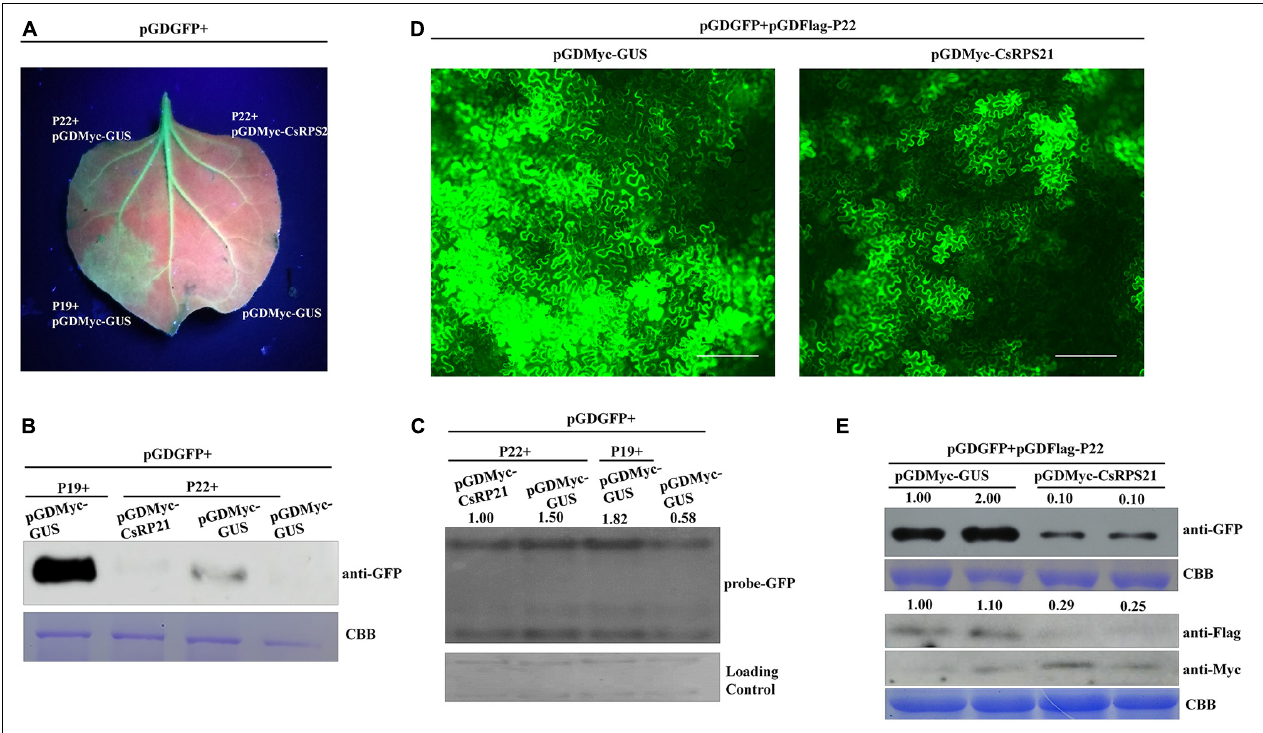
FIGURE 4 | CsRPS21 negatively regulates P22 silencing suppressor activity (A–C) Silencing suppression ability of P22 was tested in 16c N. benthamiana plants, with transient co-expression of GFP and CsRPS21 or GUS (as a control protein). GFP fluorescence was revealed by UV illumination at 5 dpi with Agrobacterium constructs. Western blotting (B) and northern blotting (C) were used to detect the accumulation of GFP. (D) N. benthamiana leaves were infiltrated with a mixture of three Agrobacterium cultures carrying pGDGFP, pGDFlag-P22, pGDMyc-GUS, or pGDMyc-CsRPS21 and photographed at 3 dpi. Images of GFP fluorescence from agroinfiltrated leaves were taken under a Nikon ECLIPSE Ti-S fluorescence microscope. Bar represents 200 µ m. (E) Western blotting analysis of protein extracted from the N . benthamiana leaves indicated above. GFP, CsRPS21 and P22 expression were confirmed using anti-GFP, anti-Myc and anti-Flag antibody. Coomassie Brilliant Blue (CBB) staining of the large subunit of Rubisco served as a loading control ( Supplementary Figure 5